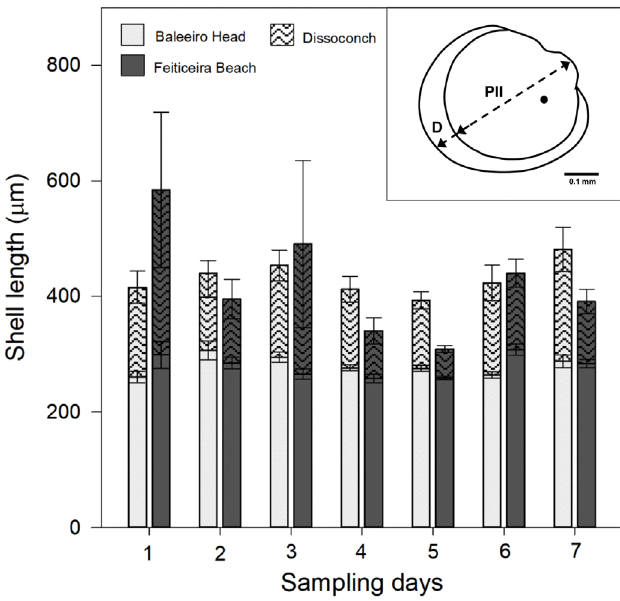
Fig. 3. Shell morphometry of Brachidontes solisianus post-larvae at Baleeiro Head and Feitieira Beach throughout the sampling period. Averages and respective SEs are shown for prodissoconch II (PII) and dissoconch (D) shells (marked in lined pattern). The indent shows the delimitation of both shells drawn from an image of a primary B. solisianus